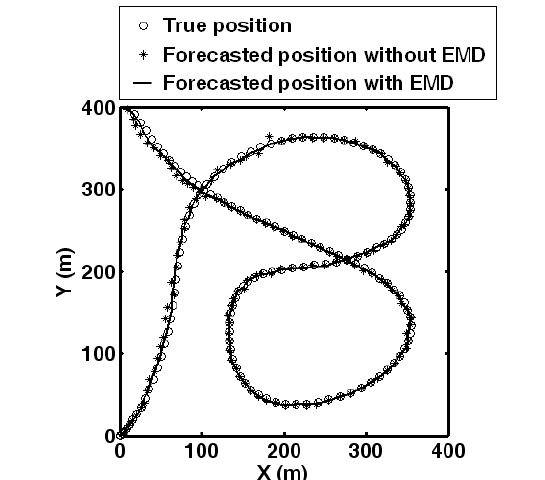
Figure 11. Target position forecasted results utilizing time series analysis with and without